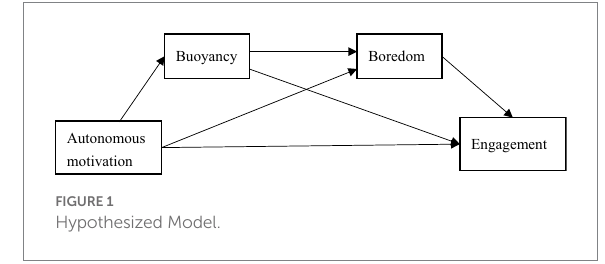
FIGURE 1 Hypothesized